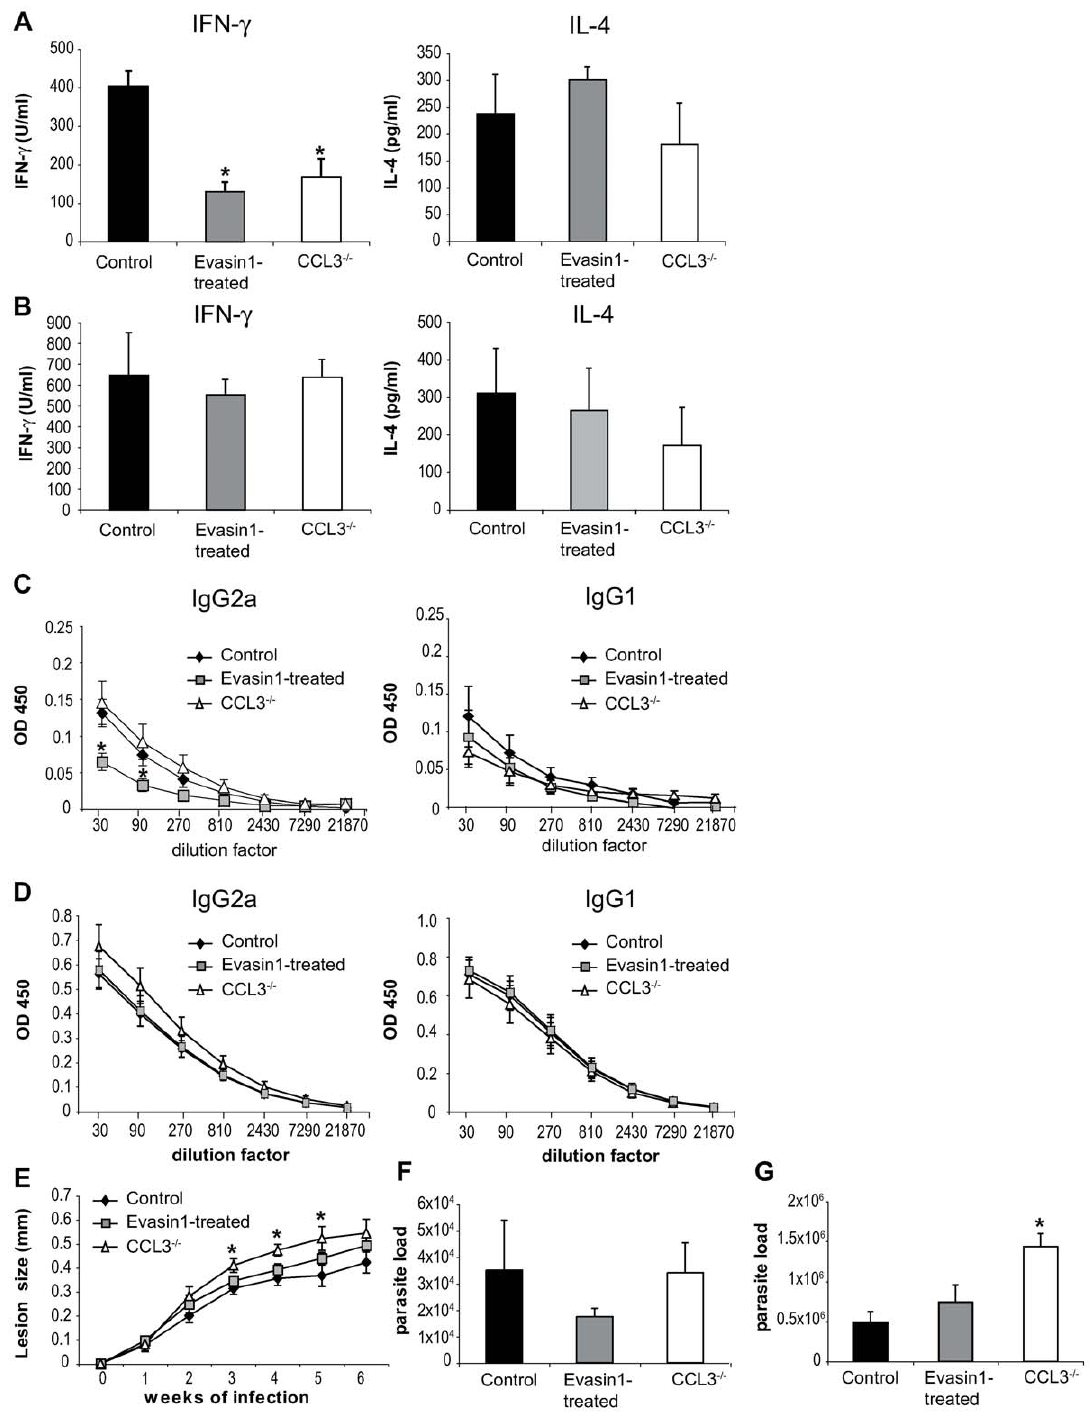
Figure 7. Depletion of CCL3 during the first day post L.major inoculation delays the development of the L.major -induced Th1 immune response. CCL3 2 / 2 mice, and C57BL/6 mice in which CCL3 was blocked by injection of Evasin-1 for the first five days post L. major inoculation, were inoculated s.c. with 3 6 10 6 L. major . CD4 + draining lymph nodes cells were prepared at days 15 (A) and 40 (B) post L. major inoculation and co-incubated with UV irradiated L. major . The resulting supernatants were monitored for their IFN c and IL-4 content by ELISA. Data are the mean of triplicate measurement 6 SEM of cytokines (n=8 mice per group). Fifteen (C) or forty (D) days post-infection L. major -specific IgG2a and IgG1 Ab production was quantified in sera from infected mice. Data are the mean triplicate OD 6 SEM of serum dilution. (E) Course of infection in CCL3 2 / 2 and Evasin-1 treated mice. Evolution of lesion size was monitored every week with a Vernier caliper. Each point represents the mean lesion size 6 SEM (n=8 per group). Parasite burden was measured by limiting dilution assay (LDA) fifteen (F) and forty (G) days post inoculation (n=8 per group). The experiments are representative of five (15 days) and three (6 weeks) independent experiments.